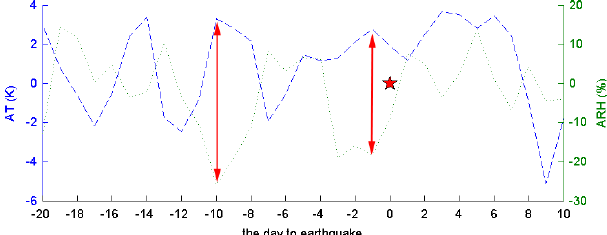
Fig. 7. Air temperature and relative humidity variation at the point 30 ◦ N, 105 ◦ E before and after the event (red star points to the day in which earthquake happened).